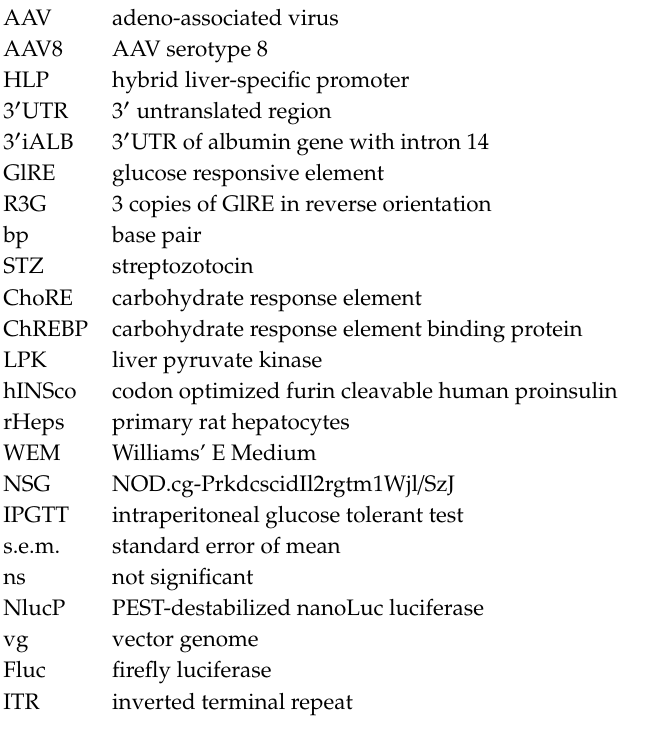
Figure S1: Schematic diagram of cloning for plasmids used in this study; Figure S2: Detail body weight and blood glucose profiles of mouse 3 in AAV8-HLP-hINSco (7.5 × 10 9 ) injected group compared to mouse 1 and 2 in the same group; Figure S3: Functionality assessment of 3 (cid:48) albumin enhancer (3 (cid:48) iALB) in AAV plasmid vector with R3GHLP glucose responsive promoter and firefly luciferase as reporter gene for its enhanced gene expression and glucose